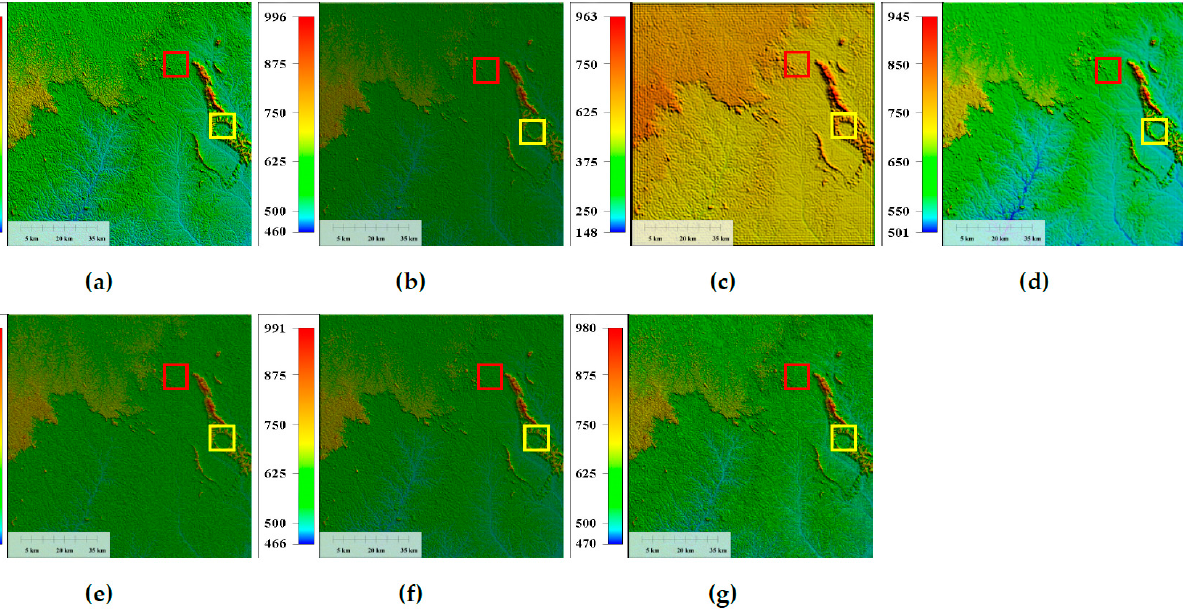
Figure 6. Local enlargement of the results of the simulation experiment for area N01E12 (Figure 5). Local enlargements for ( a ) area N01E12, ( b ) mixed error added, ( c ) low-pass filter, ( d ) TV, ( e ) UTV, ( f ) LRSID and ( g ) LRGS.